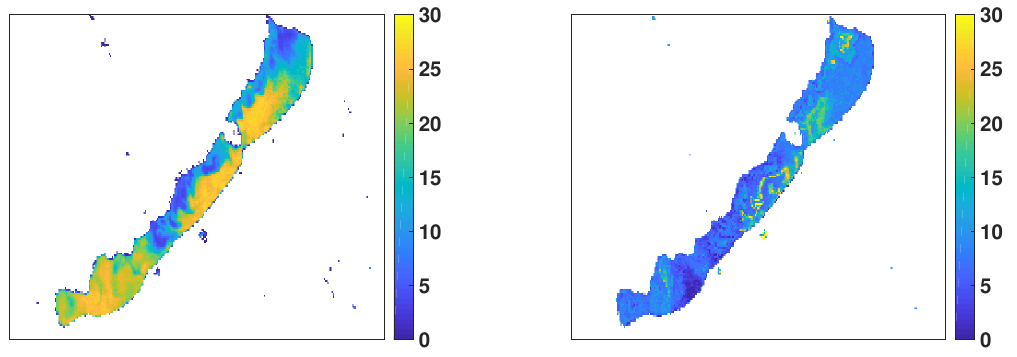
Figure 9. Chl-a content estimates by S3 OLCI ( left ) and the 5-band GPR ( right ). The units are in mg m − 3